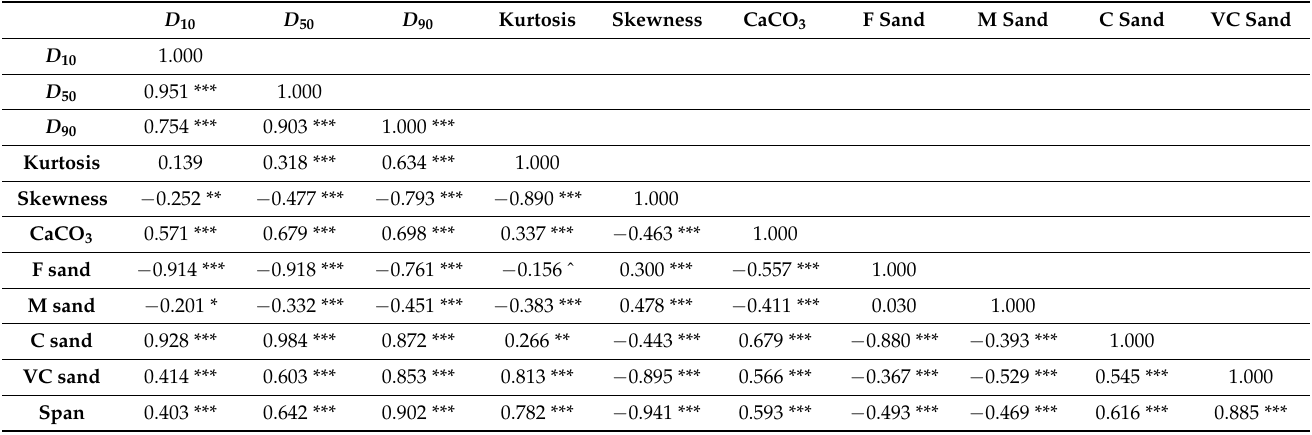
Table 3. Pearson Product Moment Correlation of different sediment properties across all samples ( n = 134). F = fine, M = medium, C = coarse and VC = very coarse. Variable span is defined in the